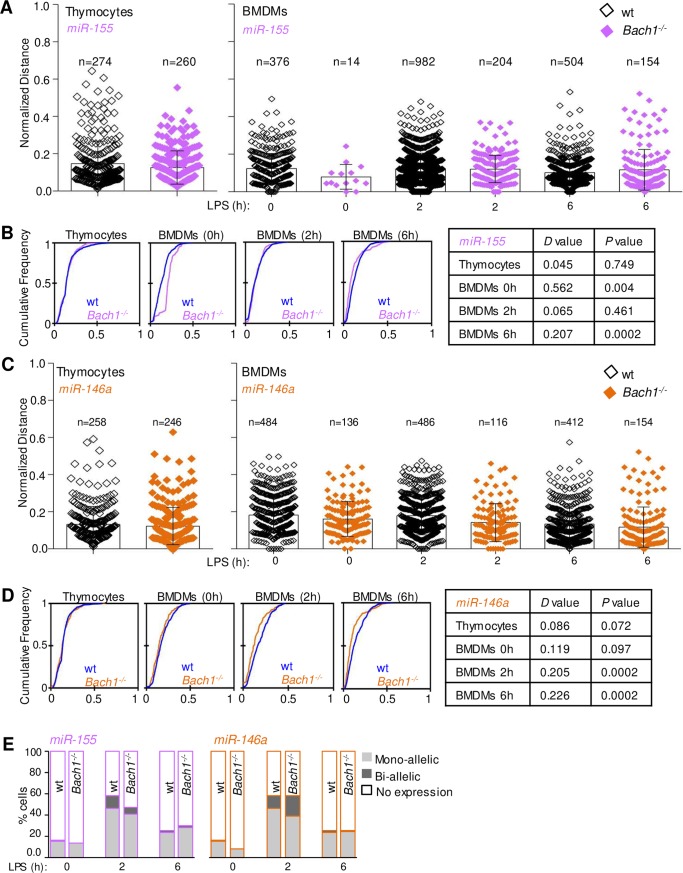
Perinuclear localization of microRNA gene loci in Bach1-/- thymocytes and BMDMs.(A) miR-155 gene alleles distribution in wild type (wt) and Bach1-/- thymocytes and BMDMs. (B) Cumulative frequency graphs and KS-test for the comparison of miR-155 gene alleles distribution in wt versus Bach1-/- thymocytes and BMDMs before and after LPS stimulation for the indicated time points. (C) miR-146α gene alleles distribution in wt and Bach1-/- thymocytes and BMDMs. (D) Cumulative frequency graphs of miR-146α gene alleles NDs in wt and Bach1-/- thymocytes and BMDMs before and after LPS stimulation for the indicated time points. KS-test analysis results are portrayed on the table. (E) Allelic expression profile of pri-miRNA-155 and pri-miRNA-146α in naive (0h) and LPS stimulated (2h, 6h) BMDMs, following RNA-DNA FISH.